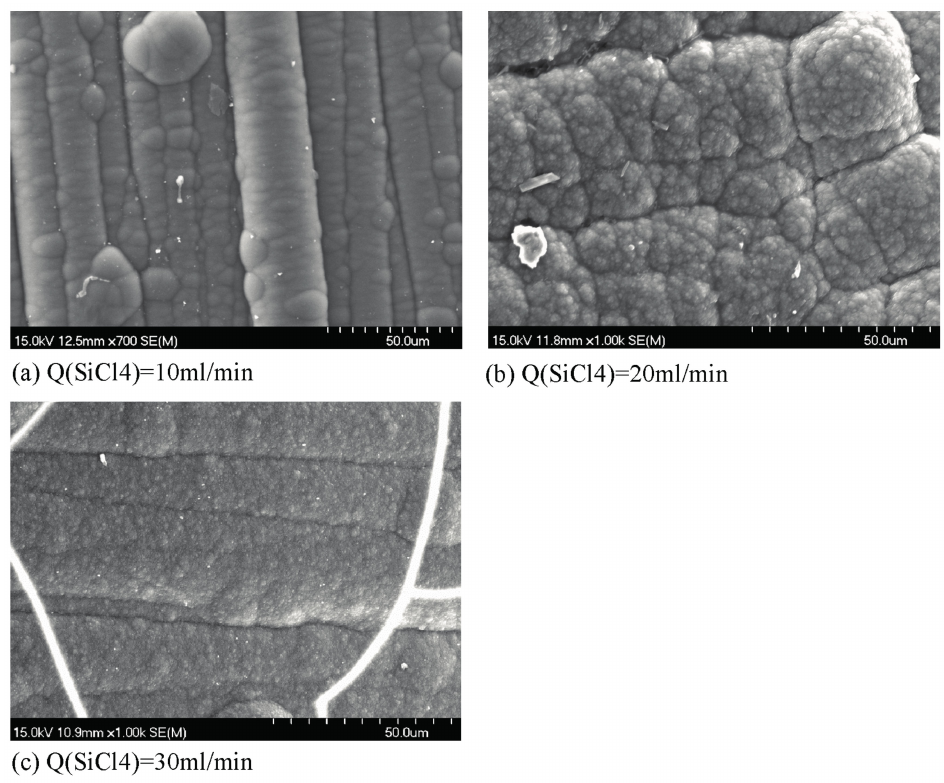
Figure 2. Scanning Electron Microscopy (SEM) images of surface morphologies of SiBN ceramic deposited at various SiCl 4 flow rates ( a ) Q(SiCl 4 ) = 10 mL/min; ( b ) Q(SiCl 4 ) = 20 mL/min; ( c ) Q(SiCl 4 ) = 30